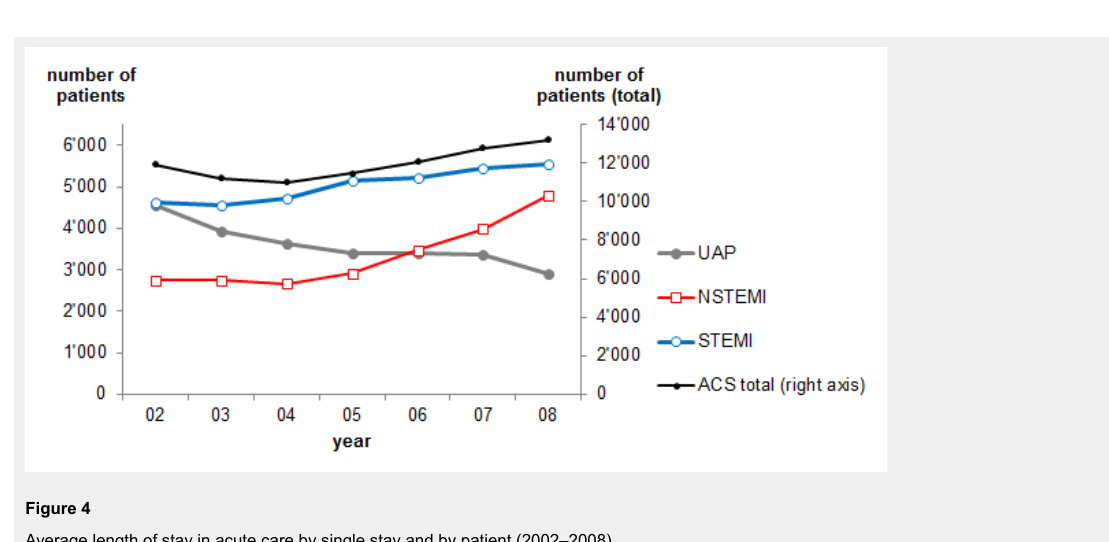
Figure 3 Number of ACS patients by main diagnosis at first hospital stay per year (2002–2008). Own calculation on the basis of MedStat [11].